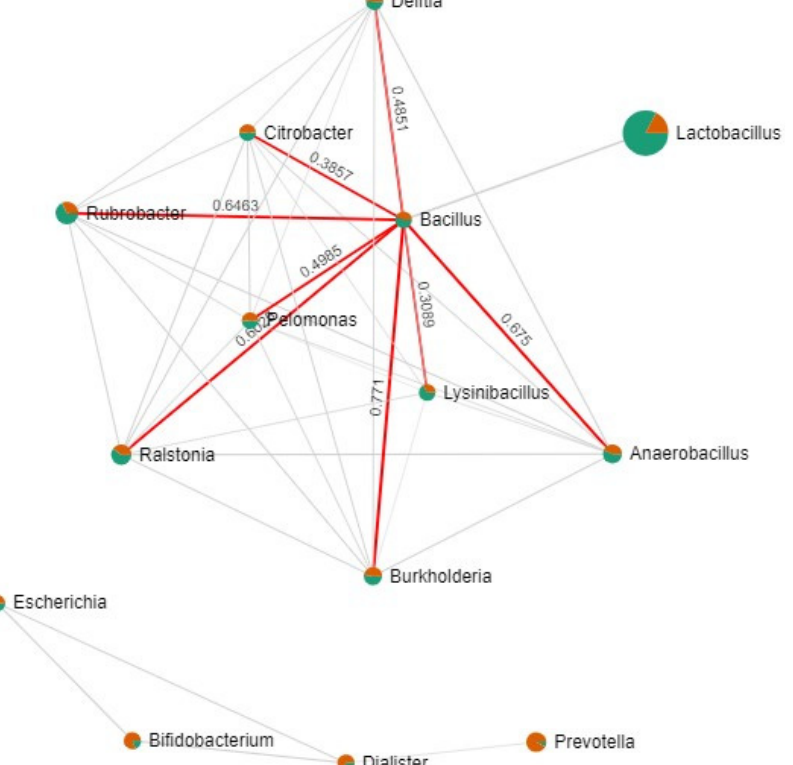
Figure 4. Bacterial network visualising the relationship between genus in all endometrial samples. Circle features: (1) size, proportional to bacterial relative abundances; (2) colour, communities for RIF group (orange) and control group (green). Line features: (1) thickness, from the most significant (thicker) to the less significant correlation (thinner); (2) colour, negative (red) and positive (grey) correlation between the genera. Each concurrent bacterial network was calculated with significant Pearson correlation coefficients.